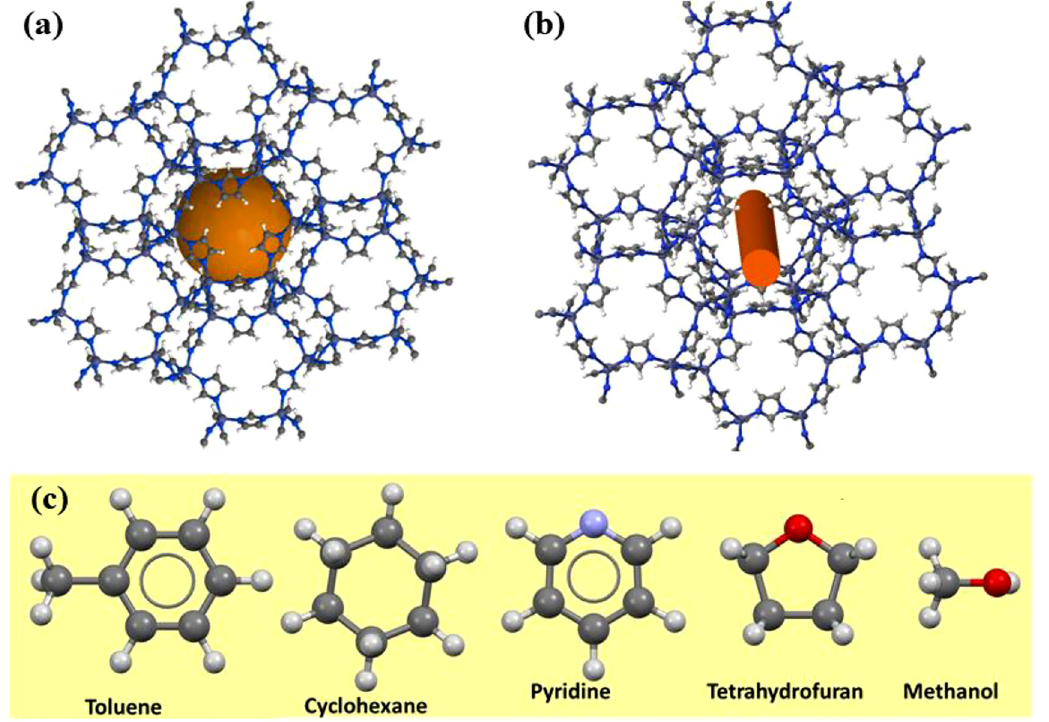
Figure 5: Three-dimension crystal structure of zeolitic imidazole frameworks (ZIF)-8 showing relatively large framework cavity (a, orange sphere) and narrow pore channel (b, orange column); (c) the con fi guration of volatile organic compounds